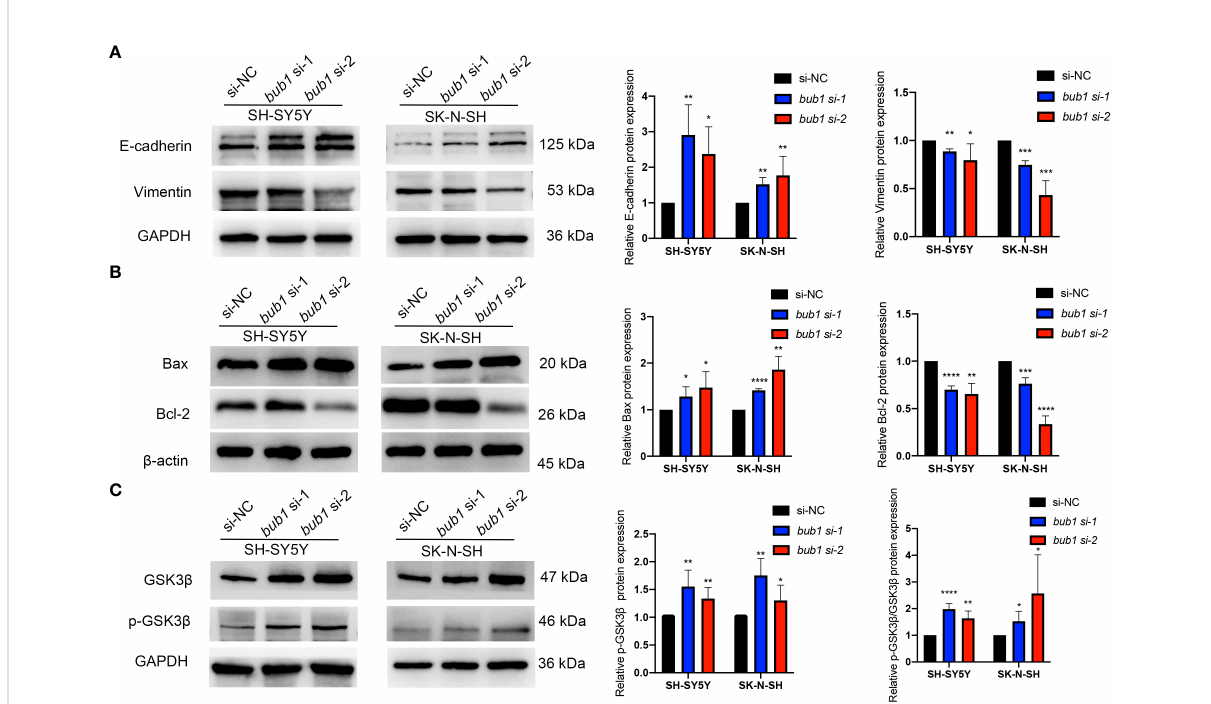
FIGURE 5 Bub1 participates in EMT, apoptosis, and other pathways. (A) Expression of EMT-related proteins E-cadherin and vimentin after silencing bub1 in two cell lines. (B) Expression of apoptosis and proliferation-related proteins Bax and Bcl-2 after silencing bub1 in two cell lines. (C) Expression of GSK3 b and p-GSK3 b proteins after silencing bub1 in two cell lines. Representative images of Western blotting are shown in the left panels. Quantitative analyses of Western blotting are displayed in the right panels. All western blotting experiments were carried out in at least three biological repeats. Data are presented as the mean ± SD. * p < 0.05, ** p < 0.01, *** p < 0.001, **** p <